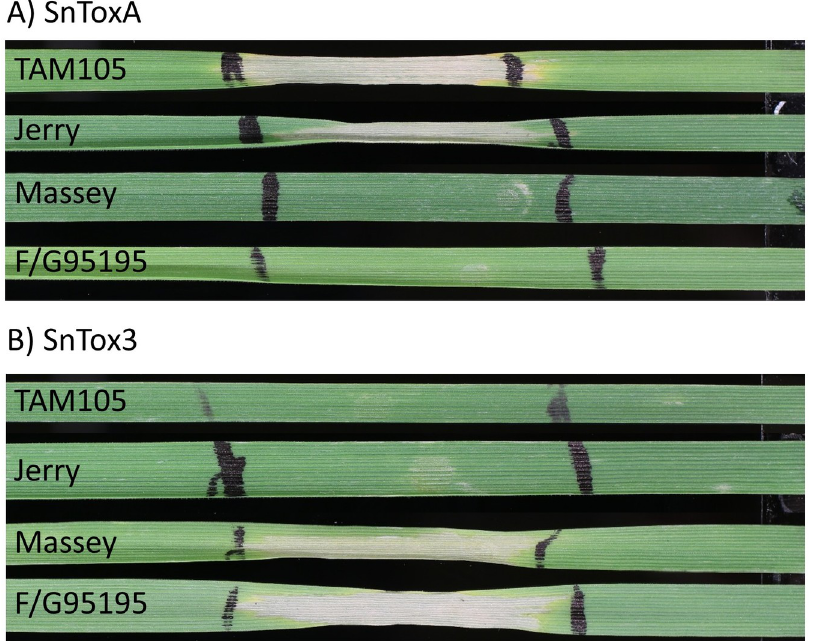
Fig 5. Sensitivity of winter wheat lines TAM105 (hard red), Jerry (hard red), Massey (soft red), and F/G95195 (soft red) to infiltrations with SnToxA (A) and SnTox3 (B). TAM105 and Jerry are sensitive to SnToxA but insensitive to SnTox3, indicating that they possess a functional Tsn1 and lack Snn3 . Massey and F/G95195 are insensitive to SnToxA but sensitive to SnTox3, indicating that they lack a functional Tsn1 but harbor Snn3 .